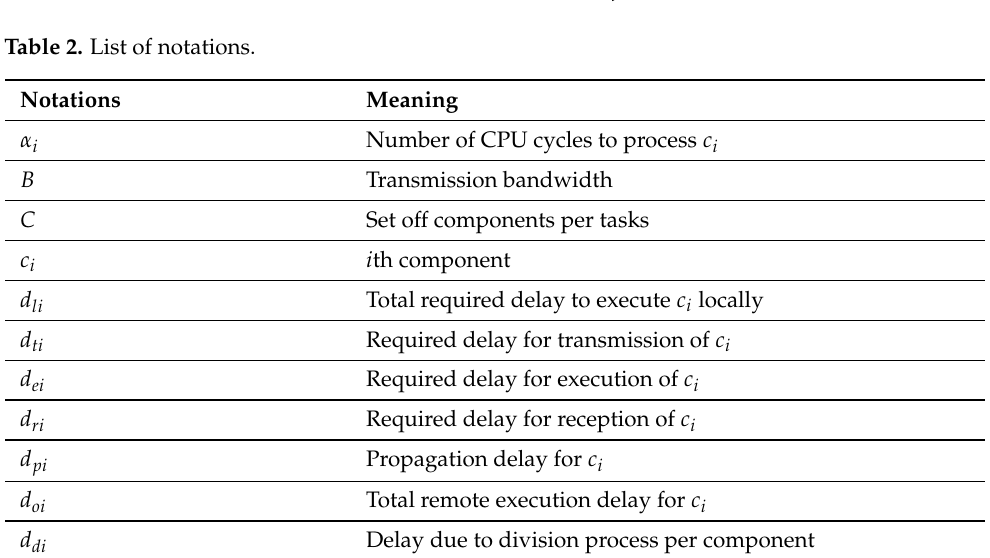
Table 2. List of